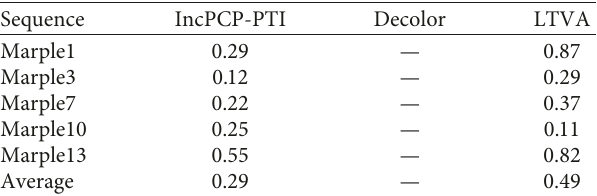
Table 3: Average F measure performance of incPCP-PTI, DECOLOR, and LTVA on the long panning Moseg